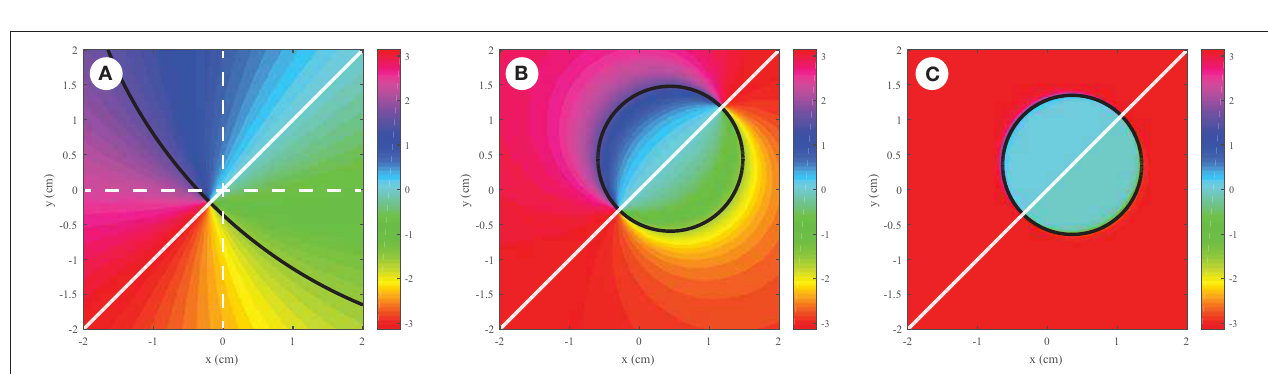
0.1 cm, (B) δ 0.5 cm, (C) δ 3 cm. = = =